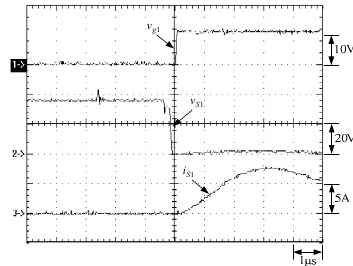
Figure 30. Waveforms pertaining to S 1 at the rated load: (1) v g 1 ; (2) v S 1 ; and (3) i S 1 .